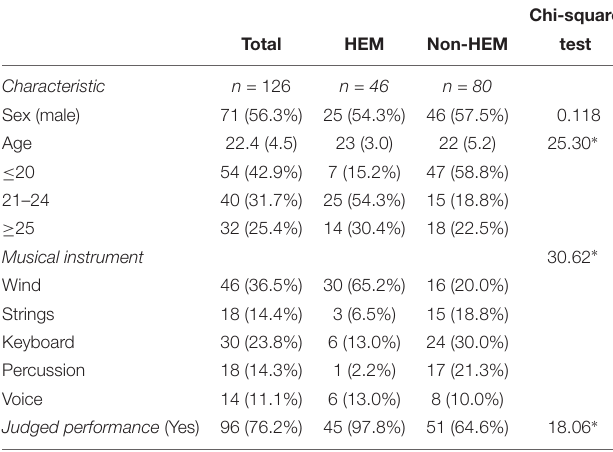
TABLE 1 | Characteristics of music college students (HEM) and amateur musicians (non-HEM) in the sample, including n (%) for categorical variables, mean (SD) for continuous variable, and Chi-square tests of